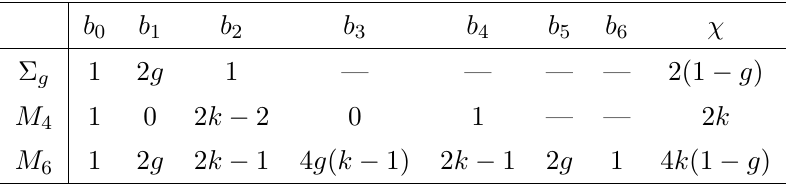
Table 1 . Betti numbers and Euler characteristics of Σ g , M 4 , M 6